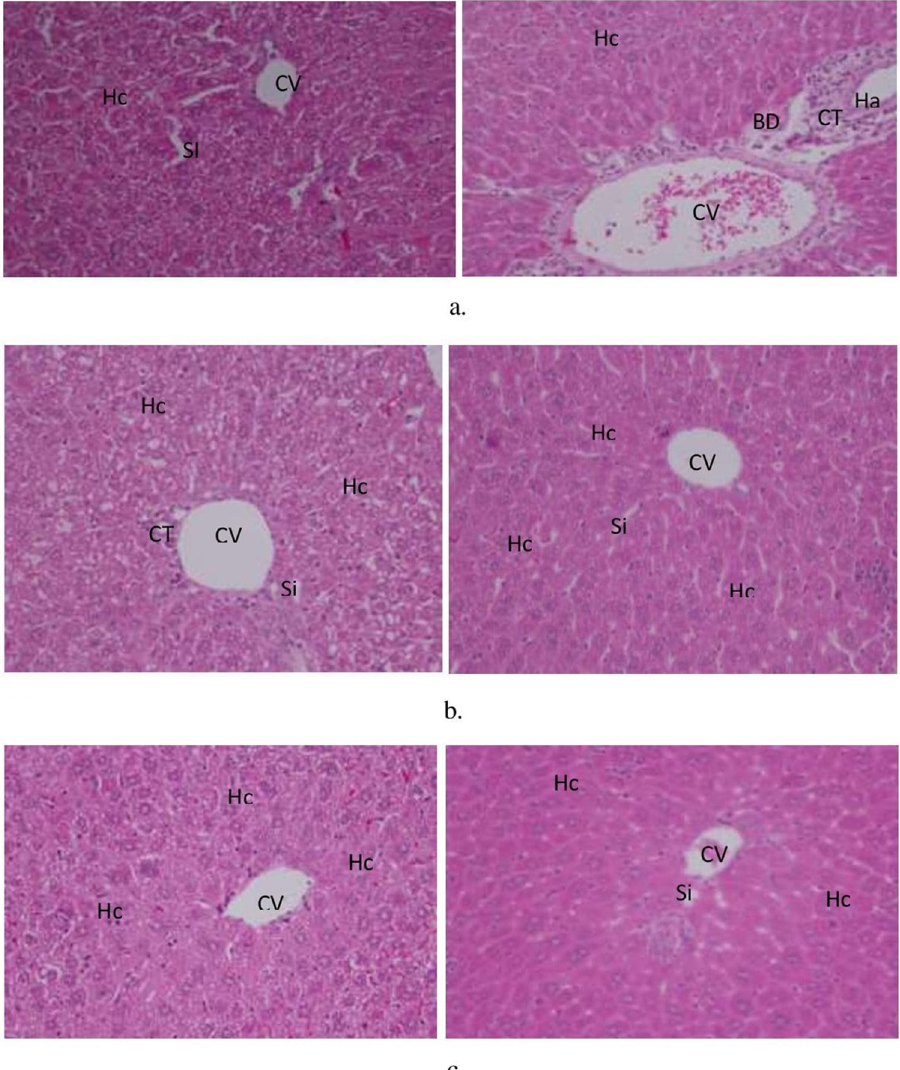
Figure 3: ( a – c ) Photomicrograph of liver sections of male and female mice treated with RVWSE before mating ( group I ) , and during pregnancy ( group II ) (× 100 or × 200 magni fi cation ) . [ CV = central vein, BD = bile duct, Hc = hepatocytes, CT = connective tissue. Si = sinusoid, Ha = Hepatic artery ] . ( a ) Group I female liver control (× 100 ) and Group I female liver treated (× 200 ) . ( b ) Group II female liver control (× 100 ) and Group II female liver treated liver (× 100 ) . ( c ) Male liver control (× 100 ) and male liver treated (× 100 )